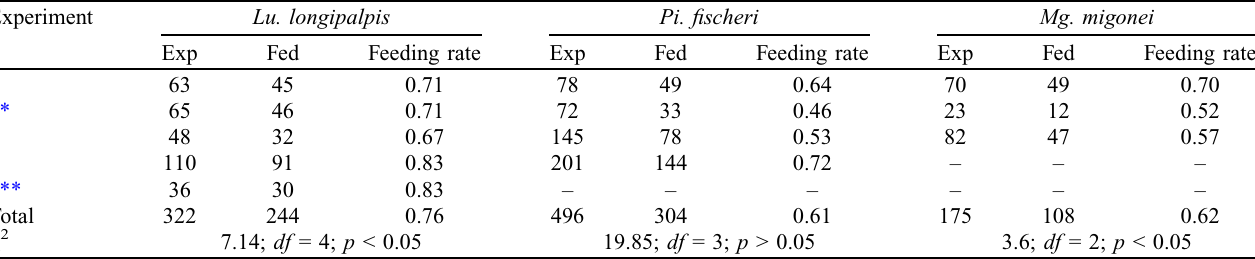
Table 2. Number of females of Lu. longipalpis , Pi. fischeri , and Mg. migonei fed on exposed dogs and feeding rate estimated under experimental conditions and comparison of the results of the v 2 test between the experiments and between the species. Experiment